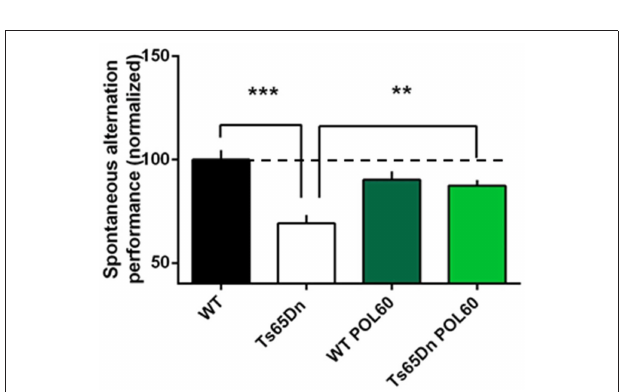
FIGURE 2 | Effect of long-term POL60 treatment on working memory in Ts65Dn mice: Per cent of alternation was assessed in four groups of mice: WT and Ts administered placebo, n = 12 ; and WT and Ts with POL60 treatment, n = 8 . The data have been normalized to the baseline level of performance of wild-type mice fed with water (dotted line). Ts65Dn mice displayed a very significant decrease of alternation under placebo condition. POL60 treatment produced improved alternation performance in the Ts65Dn mice. *** p < 0.001 , ** p < 0.01